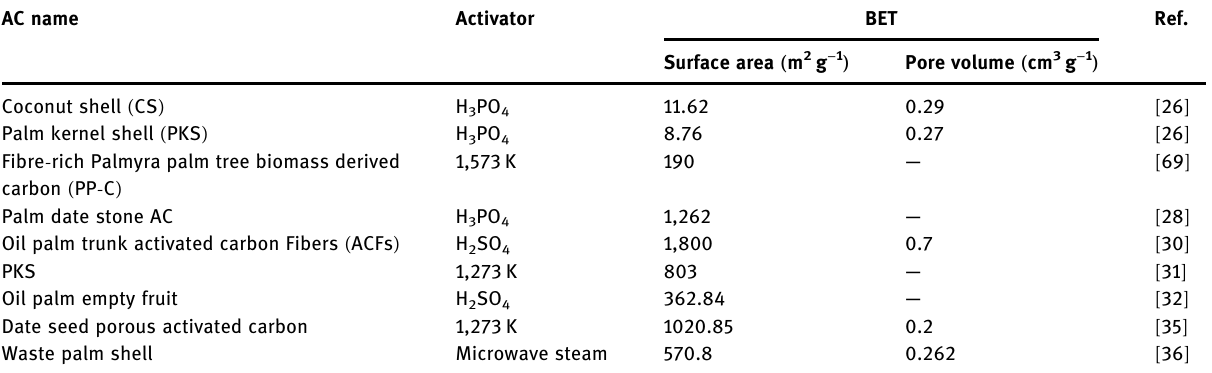
Table 3 : Physical properties of activated carbon from